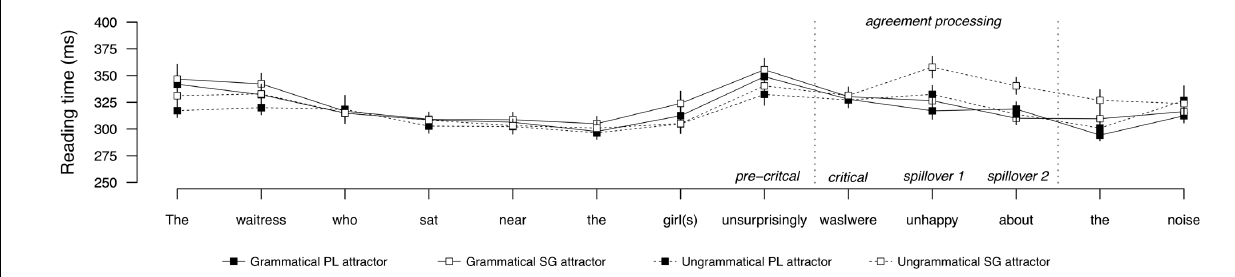
FIGURE 1 | Word-by-word reading times for the PP attractor conditions in Experiment 1. Error bars indicate standard error of the mean.